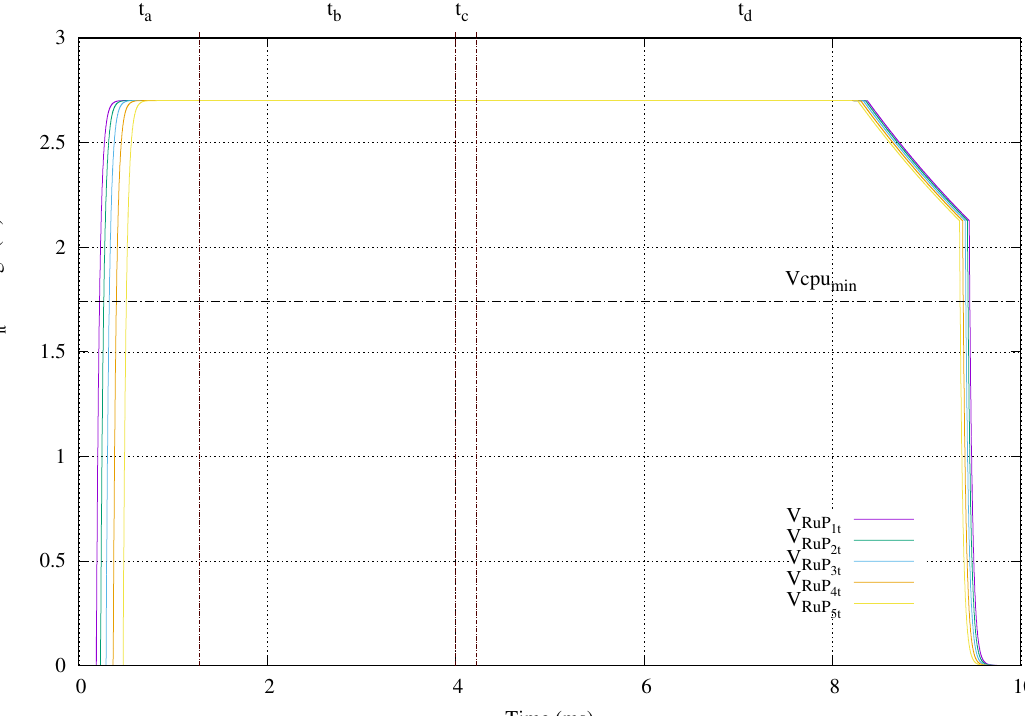
) obtained when a 4 ms tone of 134.2 kHz is it